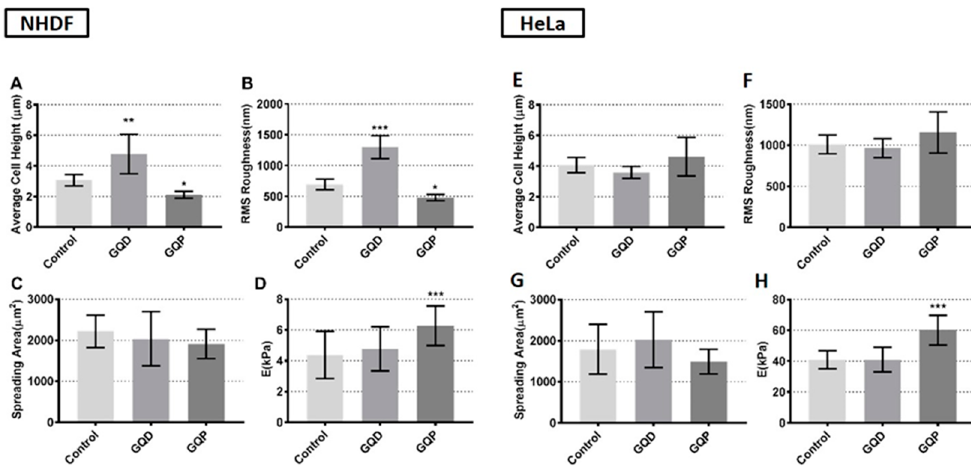
Figure 8. Quantitative analysis of cellular responses upon treatment with GQDs and GQPs in NHDF and HeLa. Graphs show ( A , E ) average cell height, ( B , F ) RMS roughness, ( C , G ) cell spreading area and ( D , H ) stiffness of cells, respectively. Experiments were repeated thrice with triplicate and significant differences between control and test samples are marked with * ( p < 0.05), ** ( p < 0.01), and *** ( p < 0.001).